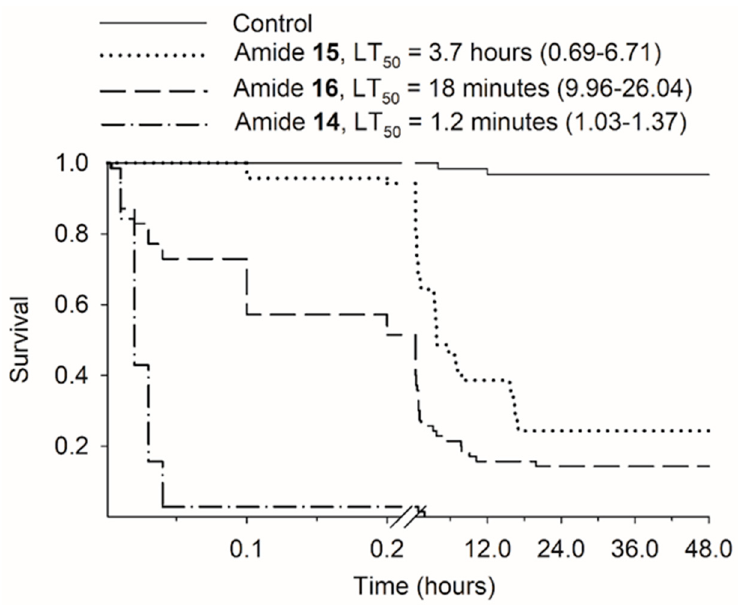
Figure 2. Survival curves of Tuta absoluta larvae topically treated with the LD 90 of the amides 14 , 15 , and 16. Control = acetone.